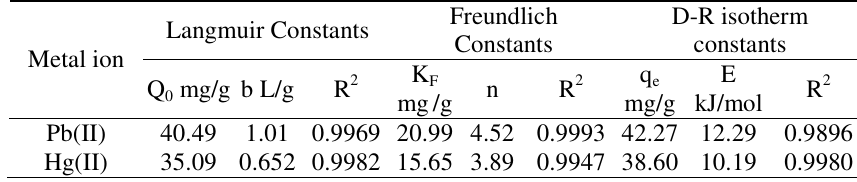
Table 2. Isotherm constants for the metal